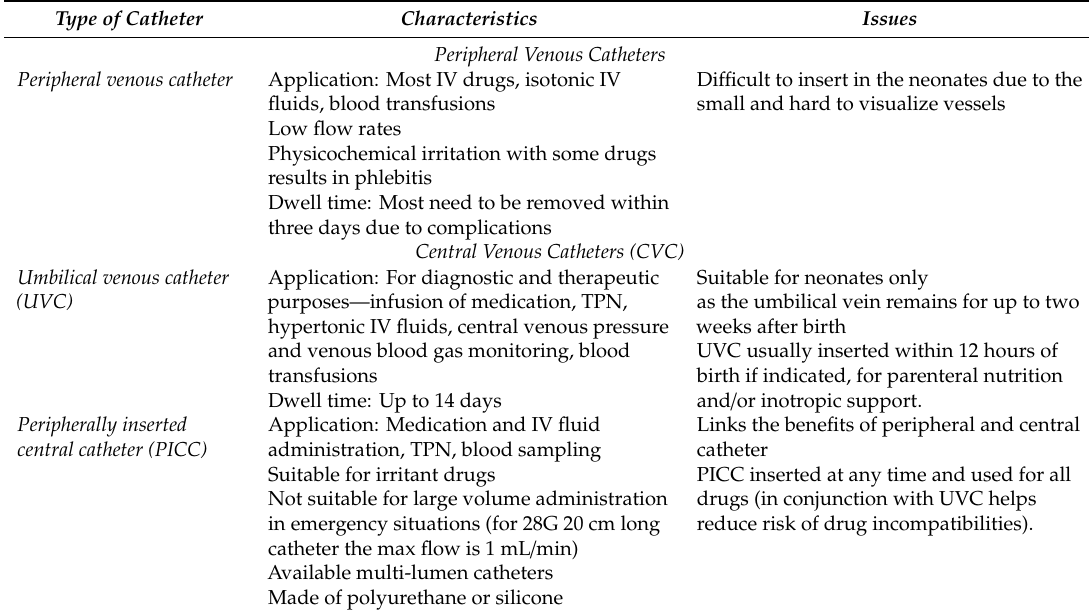
Table 1. Characteristic of available types of the vascular catheters (adapted from [21,22,24–26]. Type of